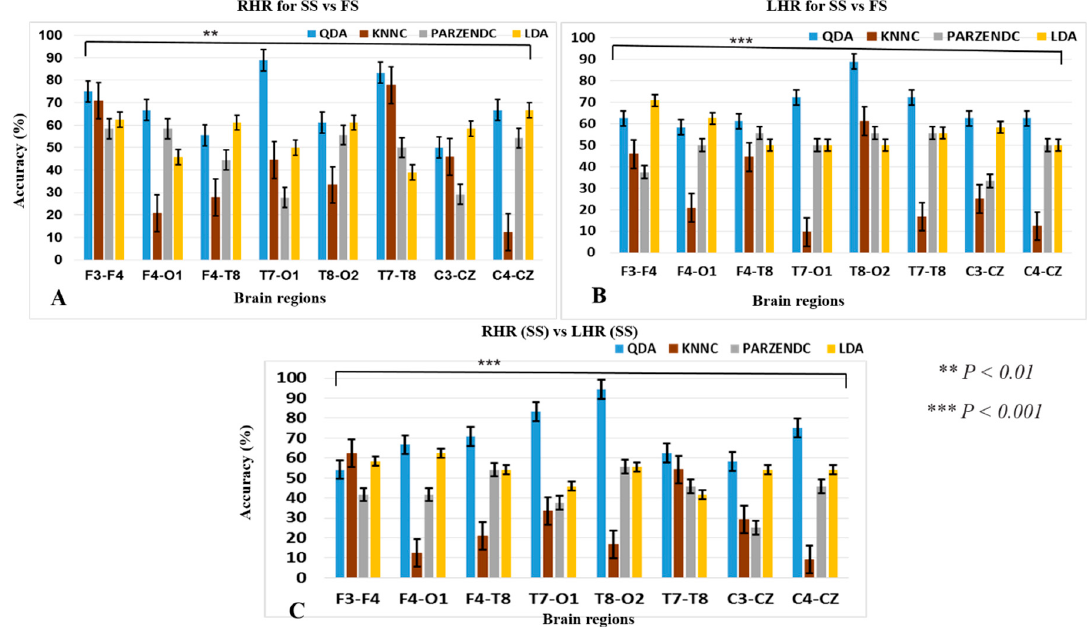
Figure 7. The parametric (LDA, QDA) and nonparametric (PARZENDC, KNNC) classification algorithms performances were compared in accuracy and standard error bars among di ff erent brain regions including F3-F4, F4-O1, F4-T8, T7-O1, T8-O2, T7-T8, C3-CZ and C4-CZ. ( A ) Presents the all classifiers outcomes during RHR for successful-stop (SS) vs. failed-stop (FS) trials; ( B ) LHR for SS vs. FS trials; ( C ) RHR (SS) vs. LHR (SS). Asterisks show the significant di ff erence in one-way ANOVA between the QDA, KNNC, PARZENDC and LDA during RHR [ F (3, 28) = 4.51, ** p < 0.01; Figure 7A]. The one-way ANOVA revealed the significant di ff erence in QDA, KNNC, PARZENDC and LDA under LHR [ F (3, 28) = 14.07, *** p < 0.001; Figure 7B], and [ F (3, 28) s = 13.61, *** p < 0.001; Figure 7C] during RHR (SS) vs. LHR (SS).